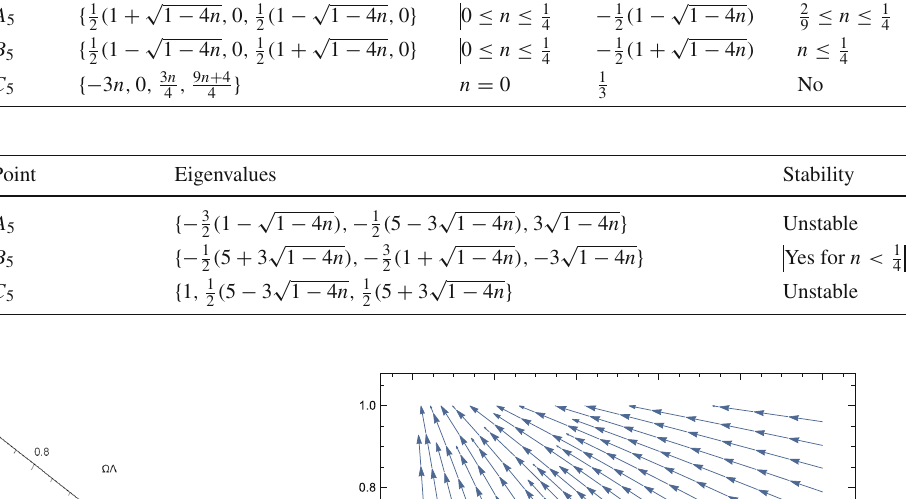
physical quantities for Case E